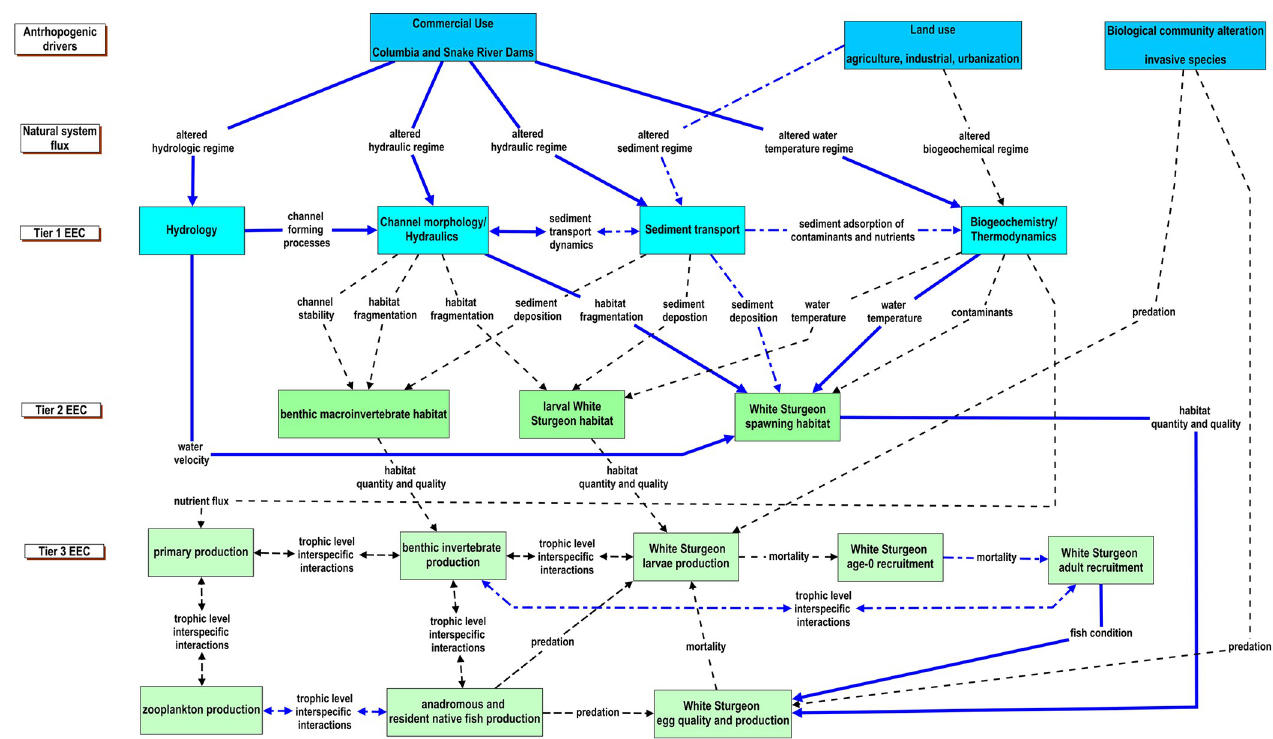
Fig 7. Conceptual model describing the relationship of anthropogenic drivers to essential ecosystem characteristics (EECs) affecting the recruitment of White Sturgeon in the Columbia River, U.S. Essential ecosystem characteristics (EECs) are groupings of ecosystem components. Tier 1 EECs represent physical and chemical effects; fundamental measures of process that are directly affected by anthropogenic and natural drivers. Tier 2 EECs represent a broad habitat category that is intended to encompass the physical, chemical, and biological components of the riverine habitats that influence reproduction, growth, and survival of biotic communities. The Tier 3 EECs represent components of the biological systems that respond to changes in the hierarchical components of the conceptual model. The strength of our understanding of how natural and anthropogenic drivers interact with habitats, biological systems, and fish in large rivers is represented by the different types of lines in the figure. Solid blue lines depict a strong understanding of the relationship, the dotted-dashed blue line represents a moderate understanding of the relationship, and the black dashed line represents a weak understanding of the relationship. The different types of lines also represent the strength of our understanding of within EEC-tier